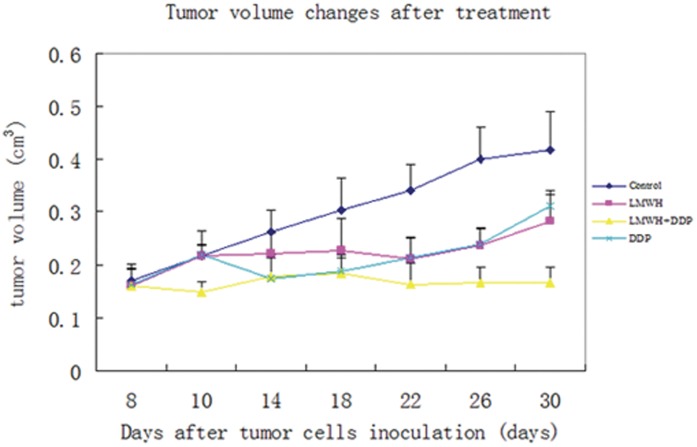
A549/DDP side population (SP) tumor xenograft growth.A549/DDP SP cells were inoculated in Balb/C nude mice and tumor volumes were recorded beginning day 1 of treatment with normal saline control, LMWH, DDP and DPP plus LWMH. The differences of tumor sizes in LMWH combined with cisplatin and cisplatin-treated tumors was significant after 25 days (0.17±0.03 cm3 vs 0.24±0.08 cm3, p<0.05) and within 23 days in control animals (0.16±0.09 cm3 vs 0.27±0.09 cm3, p<0.05). No significant difference in tumor volume of the LMWH and DDP groups was found from day 8–30.